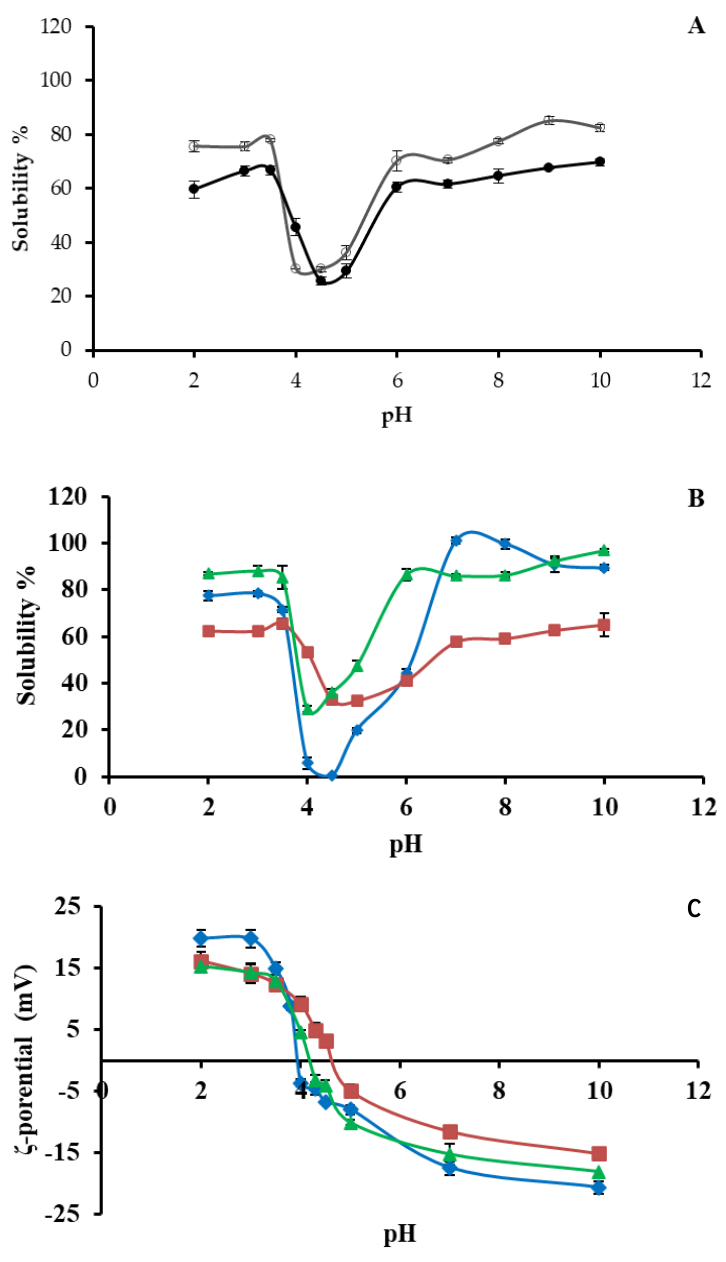
Figure 4. Effect of pH value on ( A ) protein solubility of LM ( o ), and DF (●), ( B ) protein solubility, and ( C ) ζ -potential of DF- ΑSP ( ■ ), DF- ΑIP ( ◆ ), and DF-SSP ( ▲ ). Notations as Table 1. The isoelectric point ( p I) of all samples was determined in the pH range between 4.0 and 5.0, where the minimum values of solubility were detected (30.36% at pH 4.5, 25.80% at pH 4.5, 32.47% at pH 5, 0.30% at pH 4.5, and 28.89% at pH 4.0 corresponding to LM, DF, DF-ASP, DF-AIP, and DF-SSP). Zhao et al. [15] and Bußler et al. [11] also reported that proteins extracted from freeze-dried T. molitor larvae exhibited p I within the pH range of 4.0 and 5.0 owing to considerably fewer repulsions between the protein molecules, lead- ing to their aggregation [13]. A wider range of p I (3.0 to 5.0) was noted by Azagoh et al. [13] suggesting that thermal treatment of the larvae might have affected the protein solu- bility. 3.5. ζ -Potential at Different pH Values The measurement of ζ -potential aims to estimate the accumulated charge on the sur- face of the protein molecules. The electrostatic interactions between charged particles pro- vide valuable information relating to protein adsorption phenomena. As shown in Figure 4C, the ζ -potential curve was similar for all three protein preparations. As expected, the